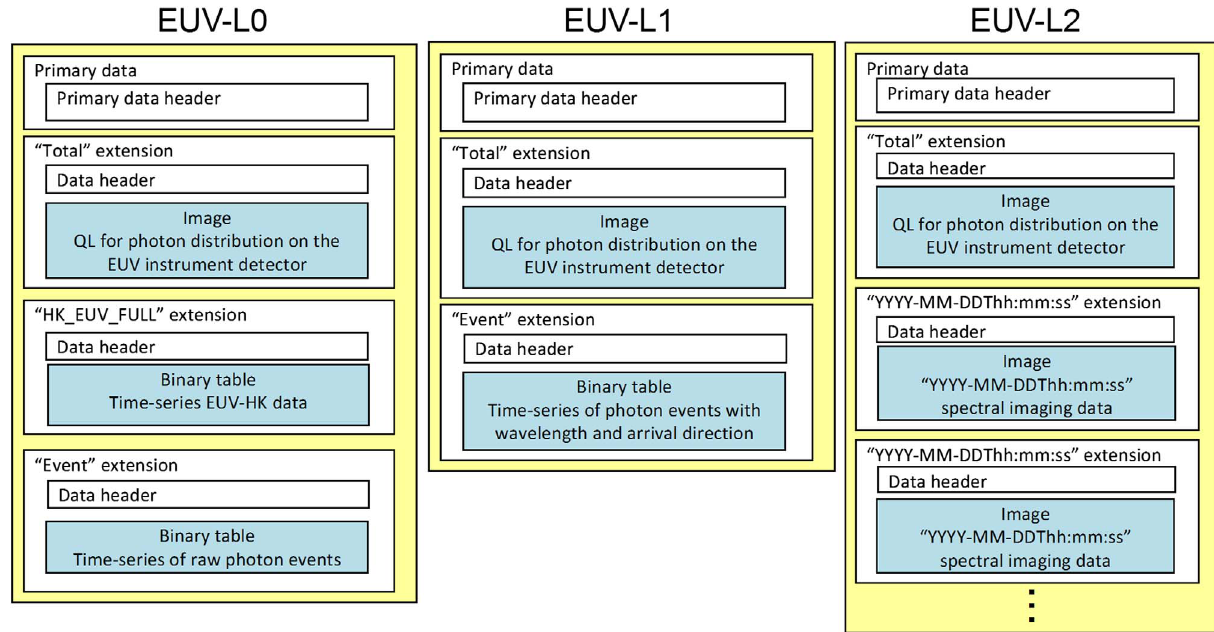
Fig. 3. FITS fi le structures of EUV-L0, -L1 and -L2. In addition to the scienti fi c data extension ( “ Event ” in EUV-L0 and -L1 and “ YYYY-MM- DDThh:mm:ss ” in EUV-L2), each fi le contains a primary header and a quick look (QL) image of photon distribution on the EUV instrument detector. EUV-L0 includes time series of the HK data used for downstream processing.